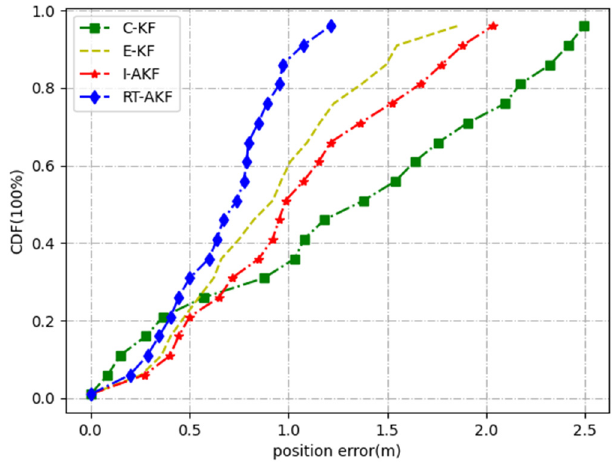
Figure 13. Accuracy comparison by different methods in segment #4.